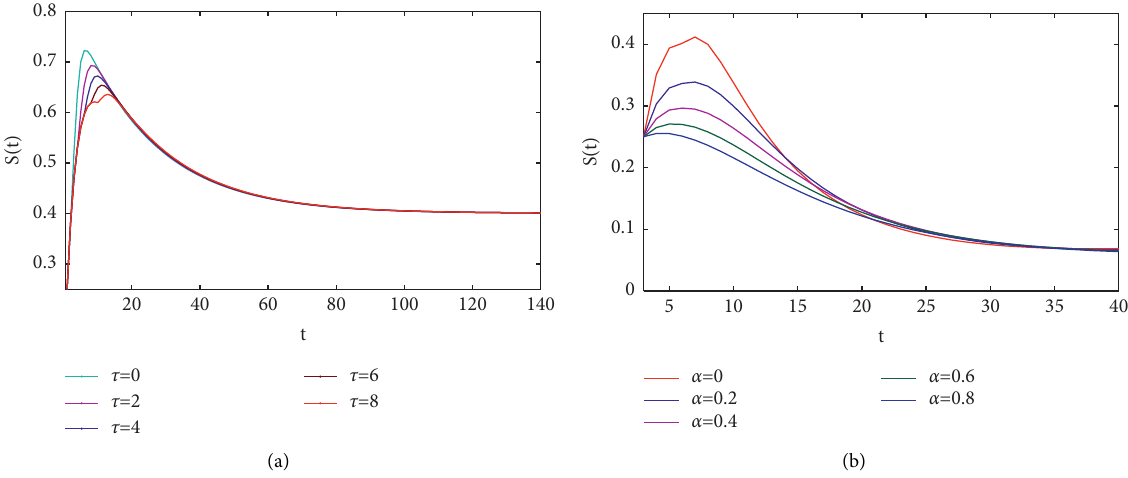
Figure 4: (a) The density of S ( t ) with different values of τ , R